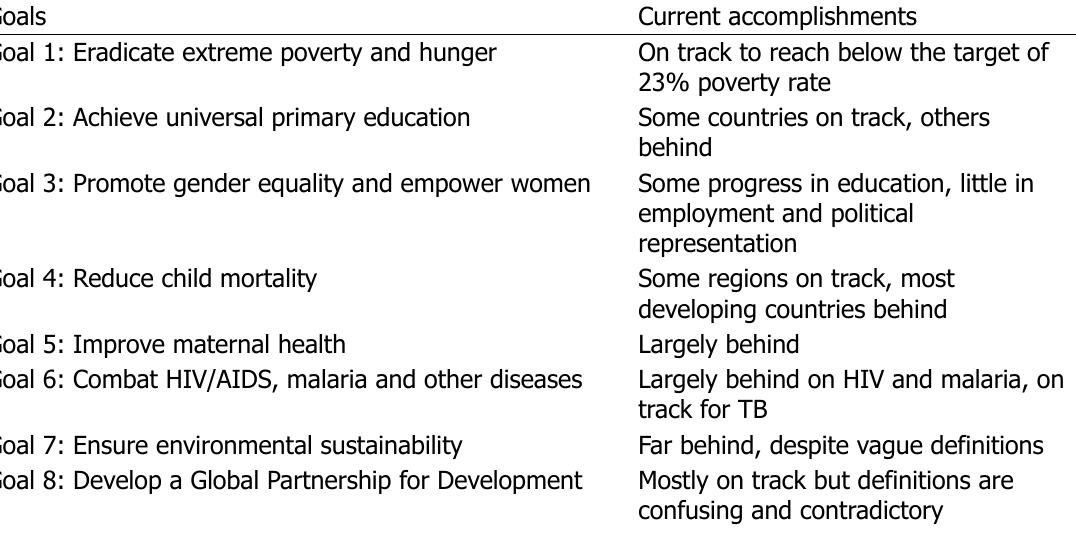
Table 3. The Millennium Development Goals and Current Accomplishments ([32,35], adapted from